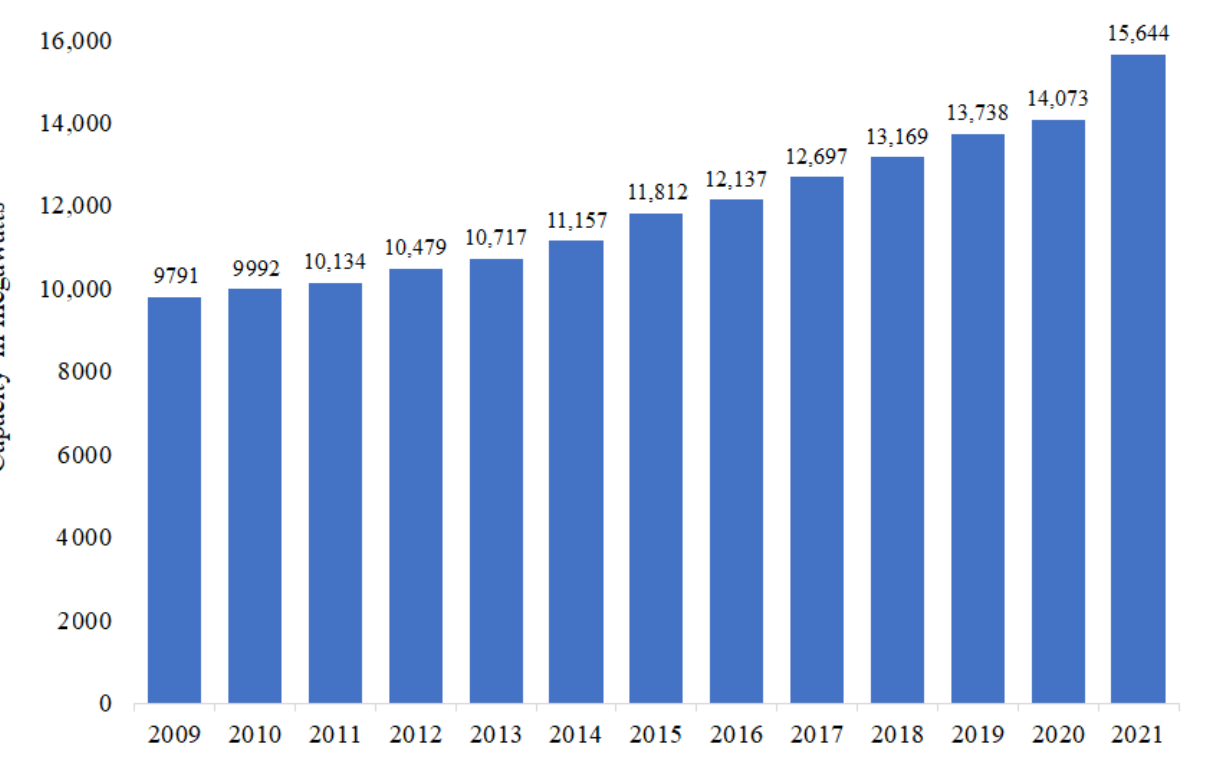
Figure 1. The installed geothermal energy capacity worldwide from 2009 to 2021 [8]. The grey prediction model (GM) is a mathematical model that can be used to charac- terize an unknown system behavior using a small data size, which contains a minimum of four data points. The grey prediction model was introduced by Dan in 1982 and remains widely applied in uncertain systems with incomplete information and discrete data for short time series prediction [16]. For the GM ( m , n ) model, m represents the order of the differential equation and n represents the number of variables that can be predicted.